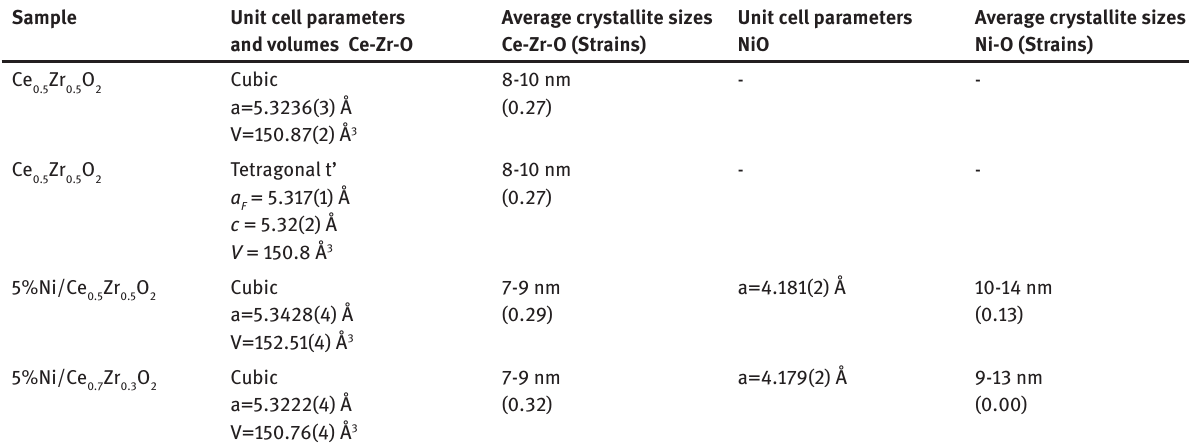
Table 1: Refined unit cell parameters, volumes and average crystallite sizes and strains.